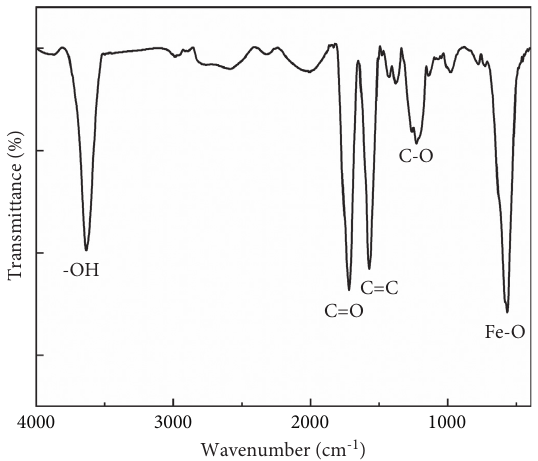
Figure 3: FTIR spectrum of the AC/Fe